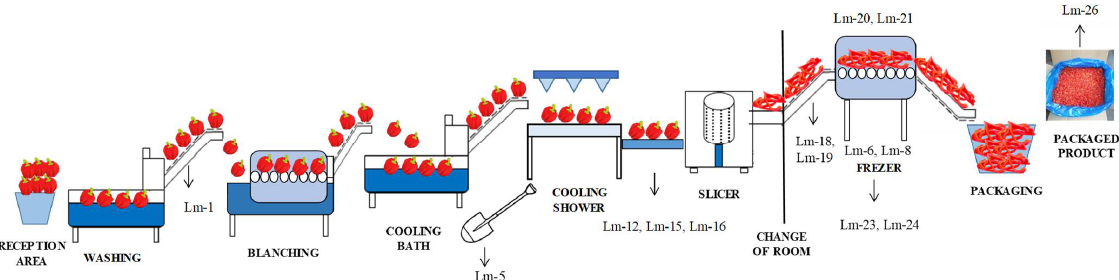
Figure 1. Scheme of sampling positive points for L. monocytogenes.